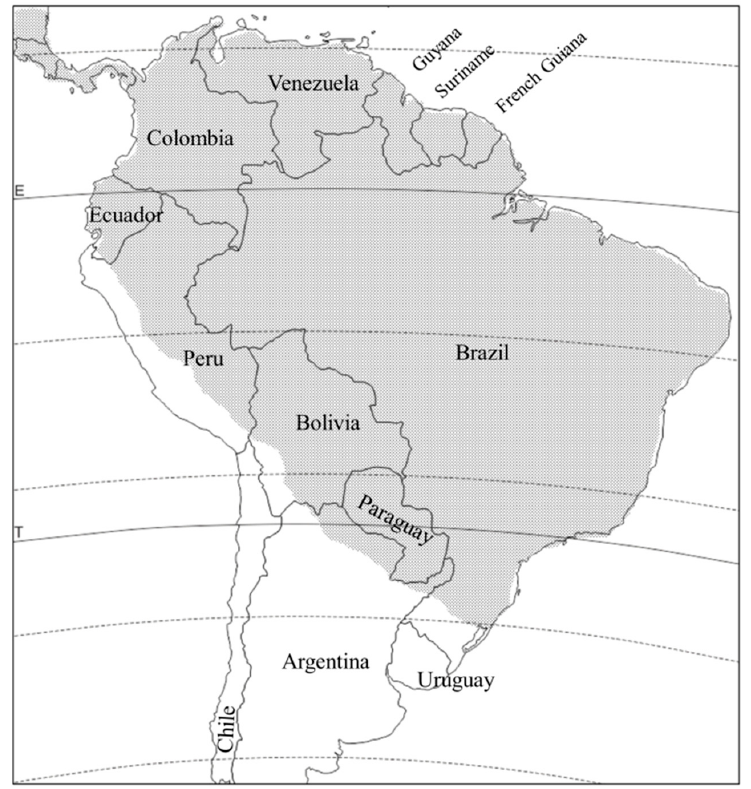
Figure 3. Distribution of Diabrotica viridula in South America (stippled area).